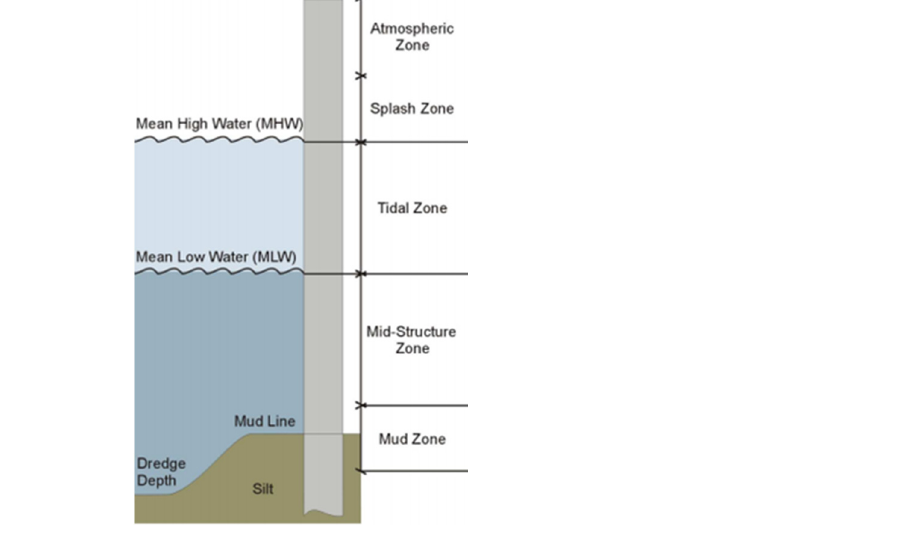
Figure 1. “Corrosion conditions at five different vertical exposure zones”, adapted from [2].